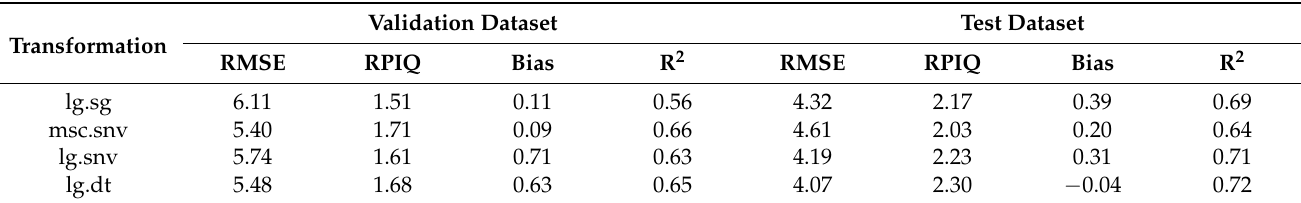
Table 2. Prediction results of the validation and test dataset from vis-NIR calibration models under four spectral preprocessing